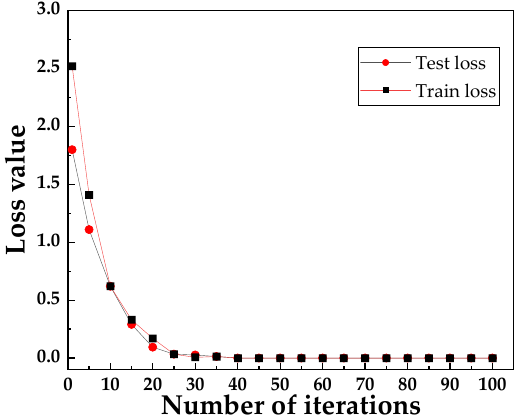
Figure 9. The variation trend of loss value for CEEMDANICA-TDCNN.